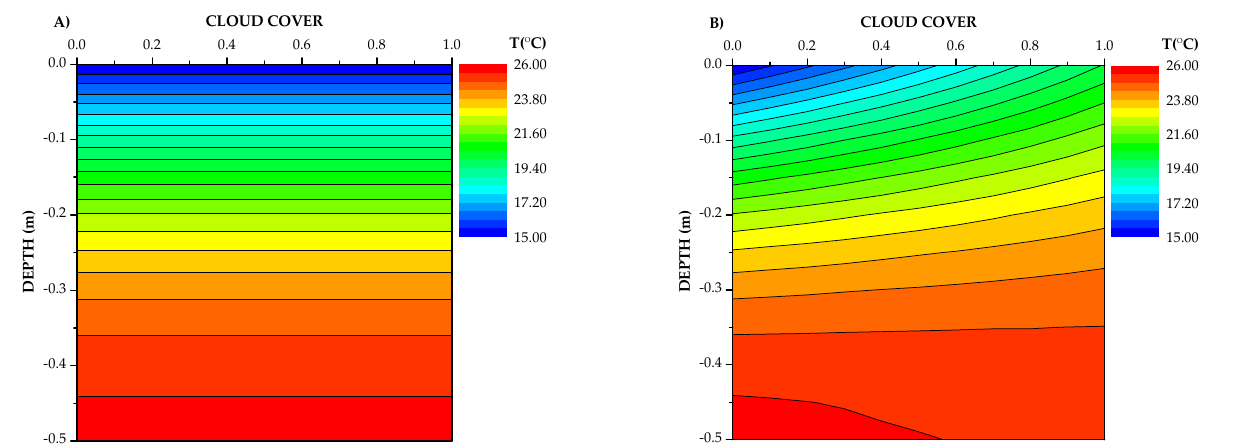
Figure 2. Soil temperature estimated by the conventional ( A ) and reformulated ( B ) models for a specific hour of the nighttime period: 1:00 a.m.